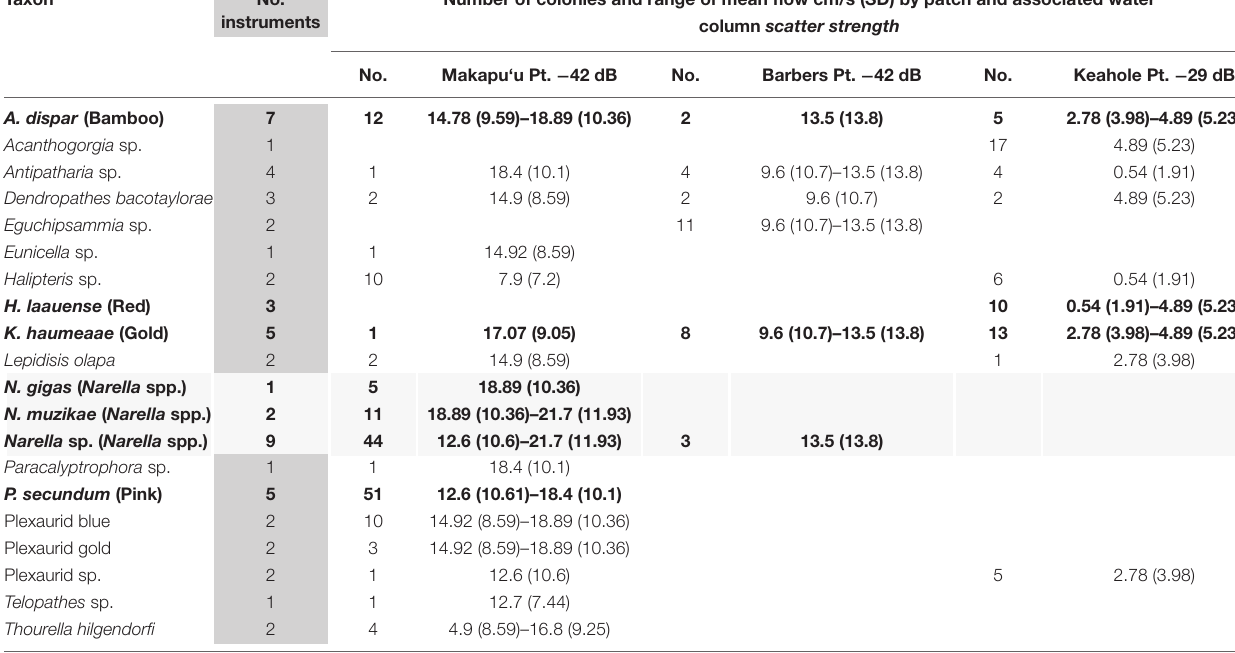
TABLE 2 | Breakdown of all sessile taxa seen within a 5-m radius of placed instruments including number of instruments, number of colonies, and the range of mean flow measured at each of the three patches with the scattering strength indicated in the column labels. Taxon No. Number of colonies and range of mean flow cm/s (SD) by patch and associated water instruments column scatter